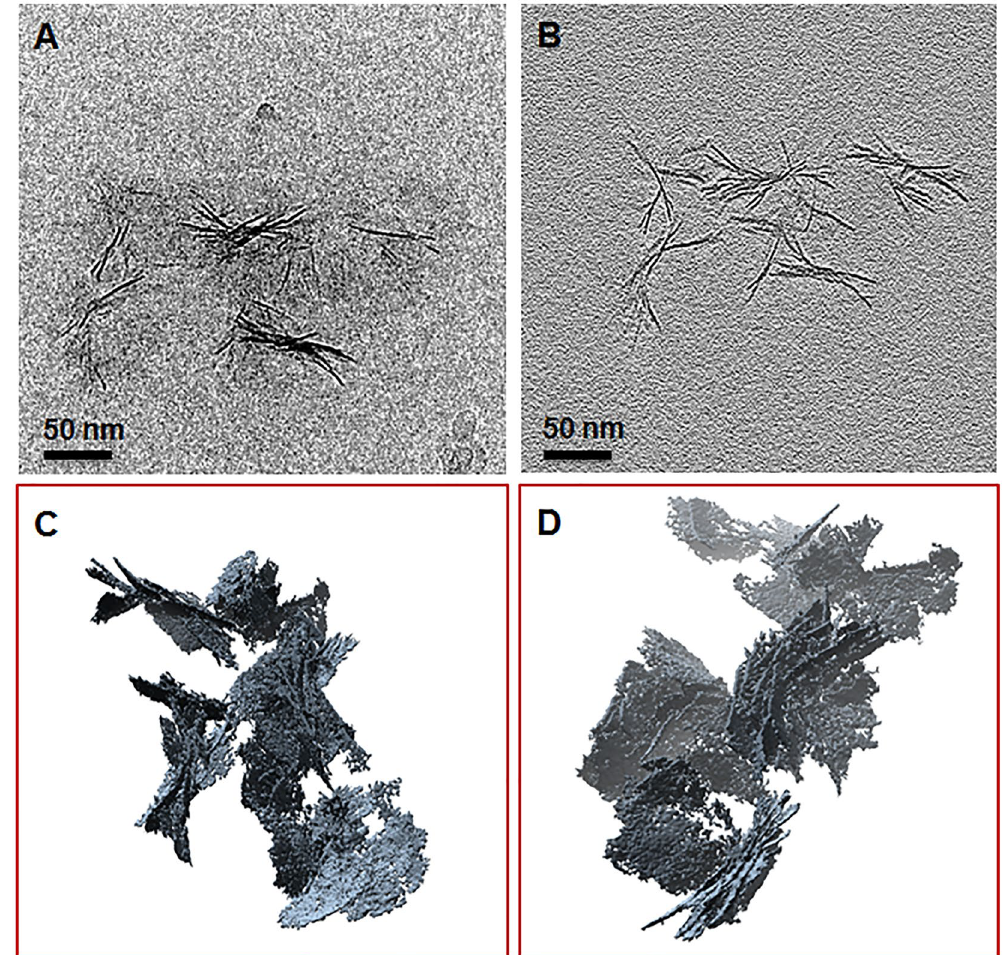
Figure 7. Snapshots from tomograms and 3D reconstructions for 20 h synthesis with 1.0 M succinate at pH 0 9.0 and 90 °C from cryo-TEM. ( A ) Raw image showing the individual aggregates of sauconite nanocrystals. ( B ) Reconstructed image of ( A ). ( C , D ) Different views of reconstructed aggregates of sauconite nanocrystals seen in ( A ) and ( B ) showing the 3D arrangement and orientation of individual nanocrystals. See Videos M2 and M3 in the Supporting